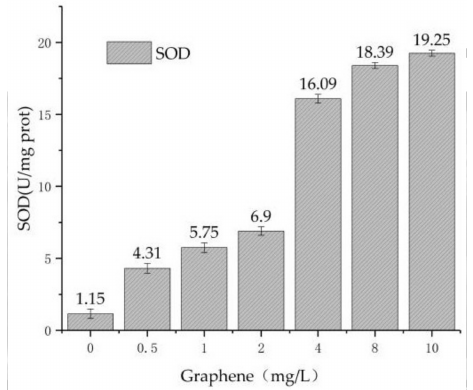
Figure 7. The variation of SOD with graphene concentration.